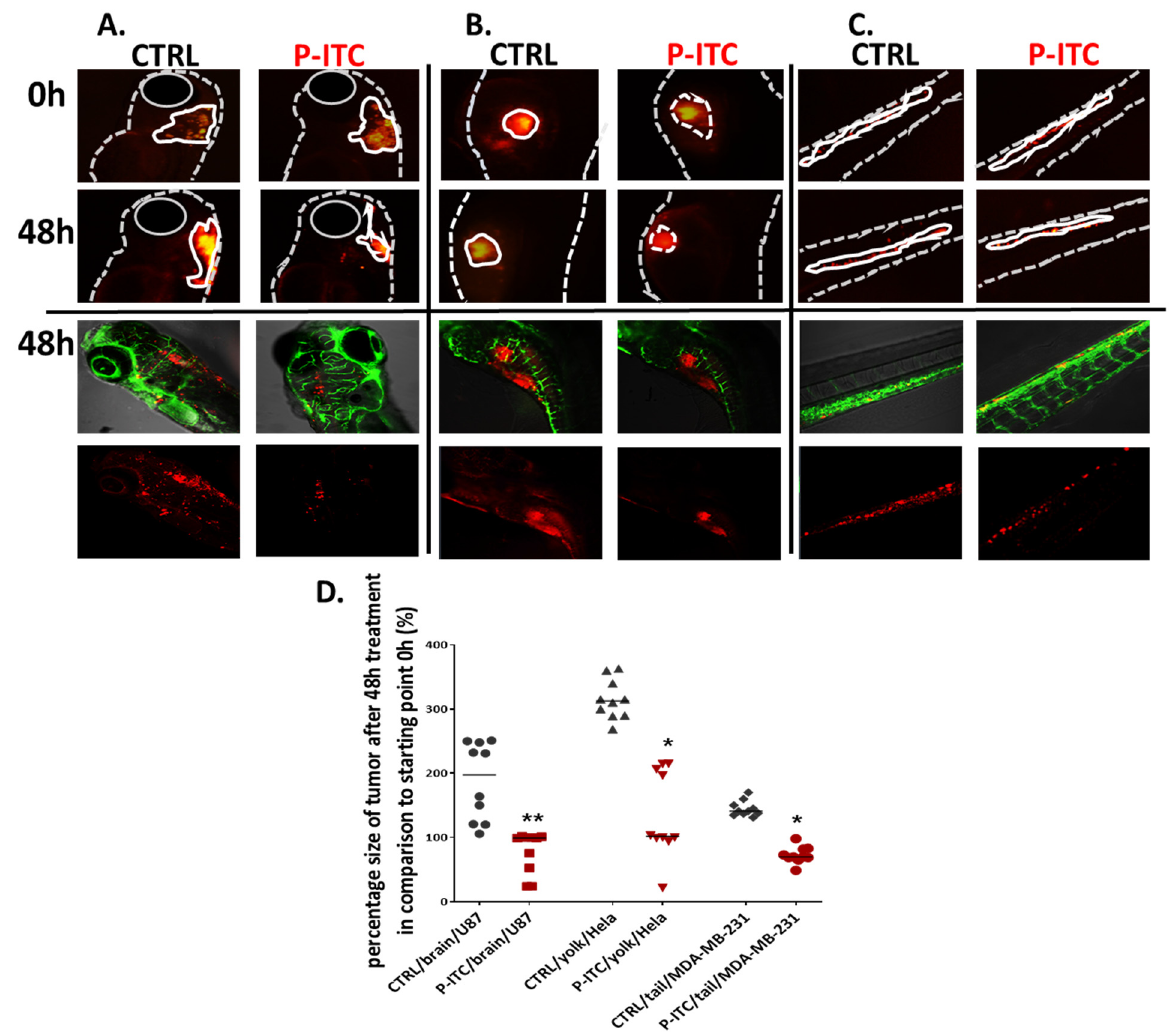
Figure 11. Phosphonate analog of sulforaphane (P-ITC) treatment inhibits tumor growth and fluorescence emitted from human glioma, cervical, and breast cancer cells grown in zebrafish embryos. The U87, HeLa and MDA-MB-231 cells were labeled with DiL (red fluorescence dye) and injected into the ( A ). hindbrain ventricle (U87), ( B ). yolk sac region (HeLa) and ( C ). in the caudal hematopoietic tissue (MDA-MB-231) of 48 h post-fertilization zebrafish embryos. After 24 h human cancer cell-positive embryos were selected and treated with 3 µM of P-ITC for 48 h. The images were taken under a fluorescence microscope and analyzed under a confocal microscope at the end of the experiment (lower panel of pictures; red–human fluorescence cells, green–blood vessels). The fluorescence emitted by the red tumor masses of each treatment group (n = 10) was measured by ImageJ and calculated in percentage. ( D ) The mass tumor growing of control and upon P-ITC treatment were measured at the beginning of the experiment (0 h; 24 h after human cells injection) and after 48 h of treatment (48 h). The presented percentage is the average tumor size after 48 h compared to starting 0 h point. Percentage of data are represented as mean ± SD; * p < 0.05 and ** p < 0.01.